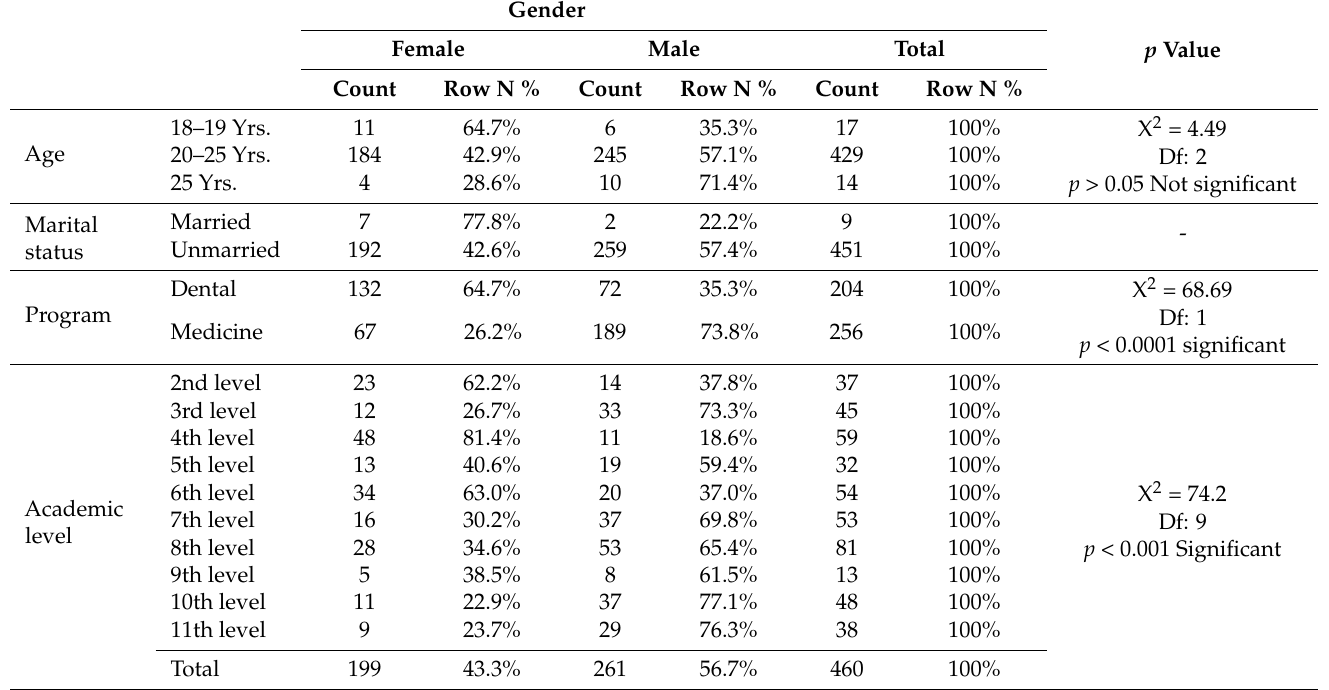
Table 1. Distribution of study subjects based on demographic profile.